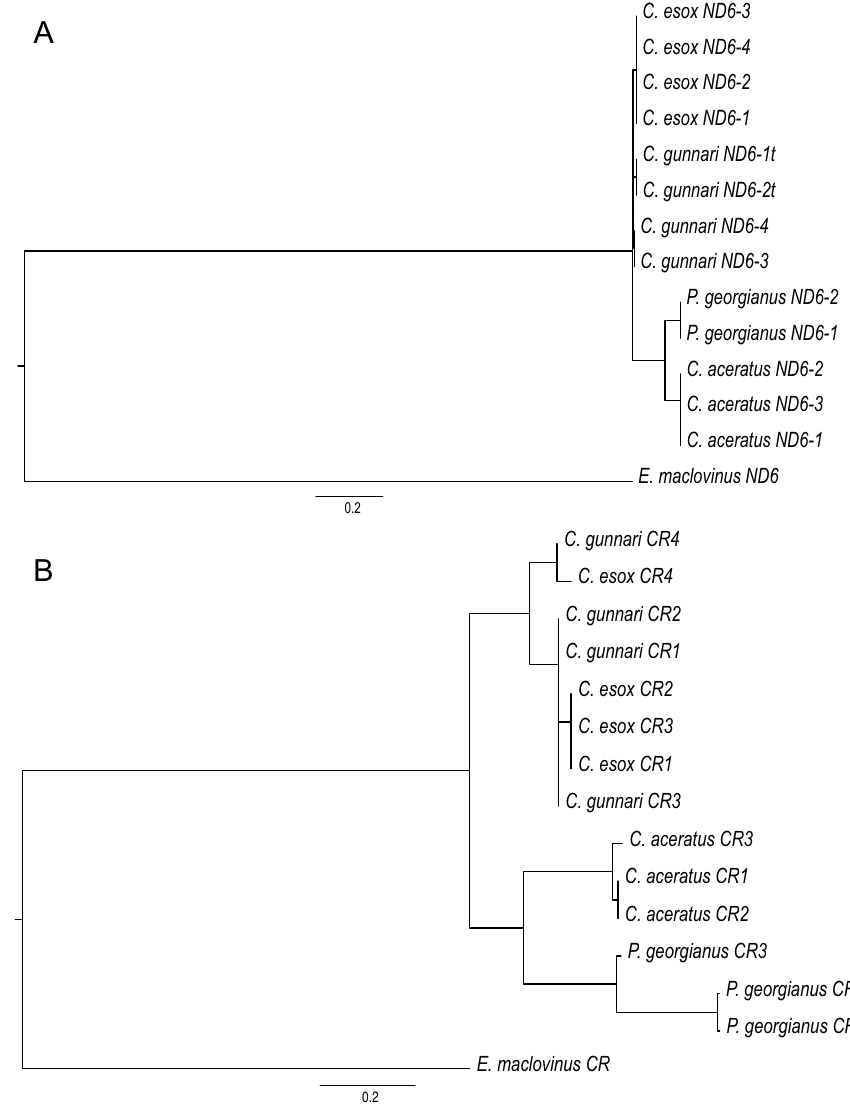
Figure 4. Phylogenetic relationships among mt elements as observed using PhyML (BIC). ( A ) Phylogenetic tree of ND6 genes of four icefishes with E. maclovinus as outgroup. ( B ) Phylogenetic tree of mt control region of four icefishes with E. maclovinus as the